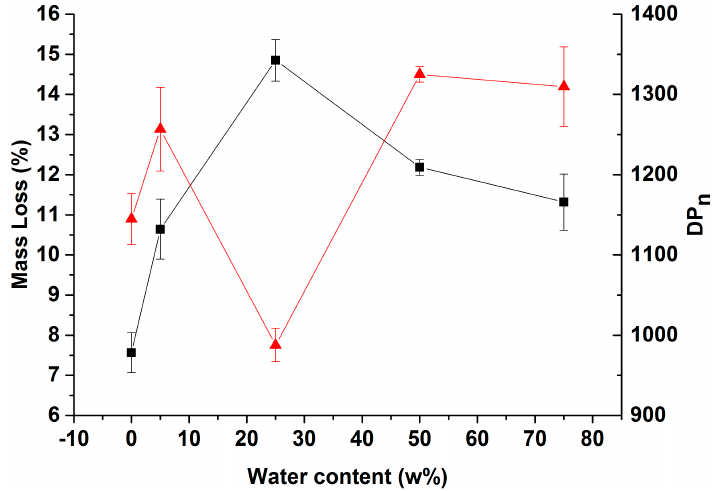
Figure 3. Averaged mass loss (black square) and number-average degree of polymerization (DP n ) (red triangle) of the treated hardwood pulps (imi-HWP) ( n = 3) in imidazole/water mixtures with different water contents at 120 °C for 24 h.